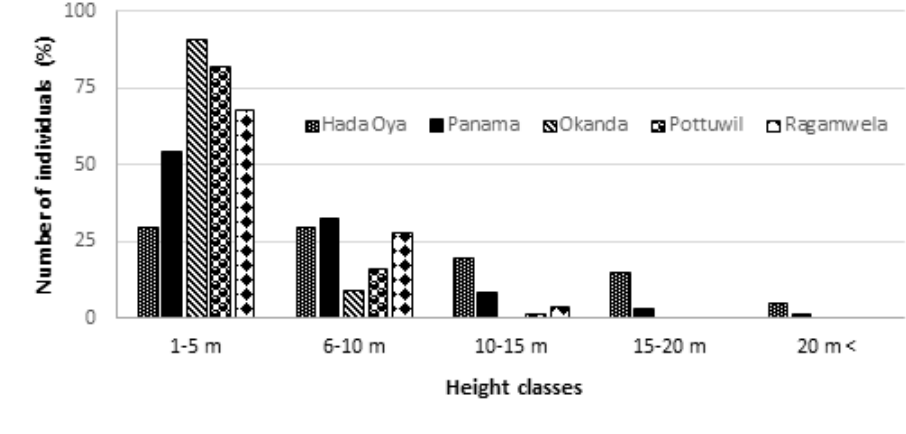
Figure 3: Height classes distribution of individuals of mangrove species in each study site.